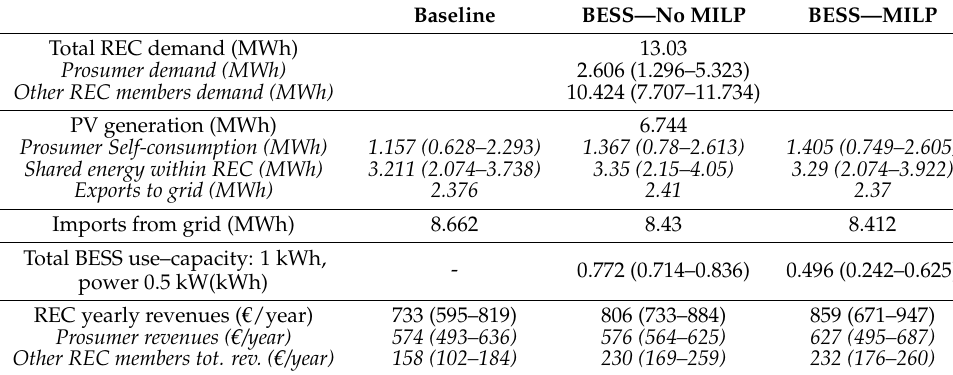
Table 4. Main techno-economic outcomes of the scenario-based analysis. Baseline BESS—No MILP